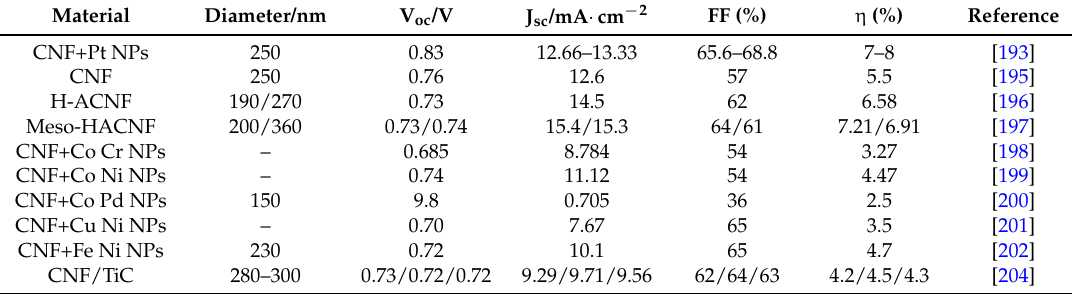
Table 4. Photovoltaic performance parameters of dye-sensitized solar cells (DSSCs) with electrospun fibers. FF: fill factor = V max ˆ J max / V oc ˆ J sc .